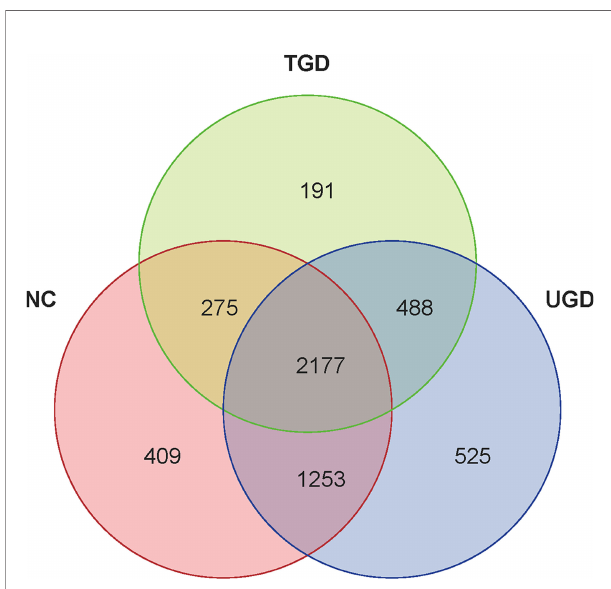
FIGURE 1 | Venn diagram of the three groups at the OTU level. Each circle represents the corresponding group, the overlapping area between the circles indicates the common OTUs between the groups, and the number within each block represents the number of common or unique OTUs contained in the